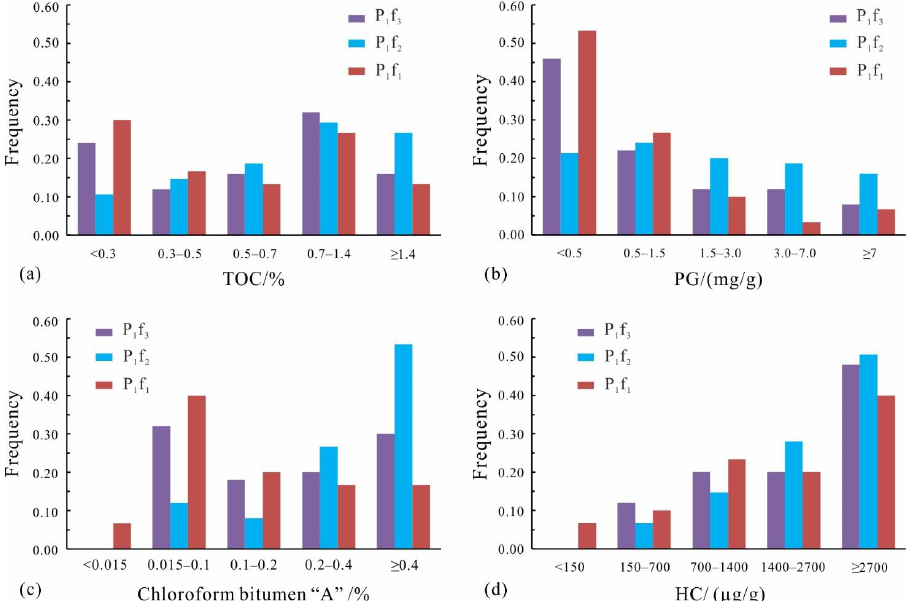
Figure 6. Distribution frequency of abundance of organic matter indicators in different members of Fengcheng Formation: ( a ) TOC; ( b ) PG; ( c ) chloroform bitumen “ A ” ; ( d ) HC. Fengcheng Formation: ( a ) TOC; ( b ) PG; ( c ) chloroform bitumen “A”; ( d )